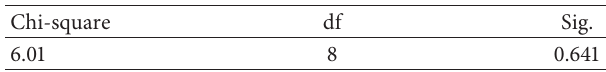
Table 5: The H-L test